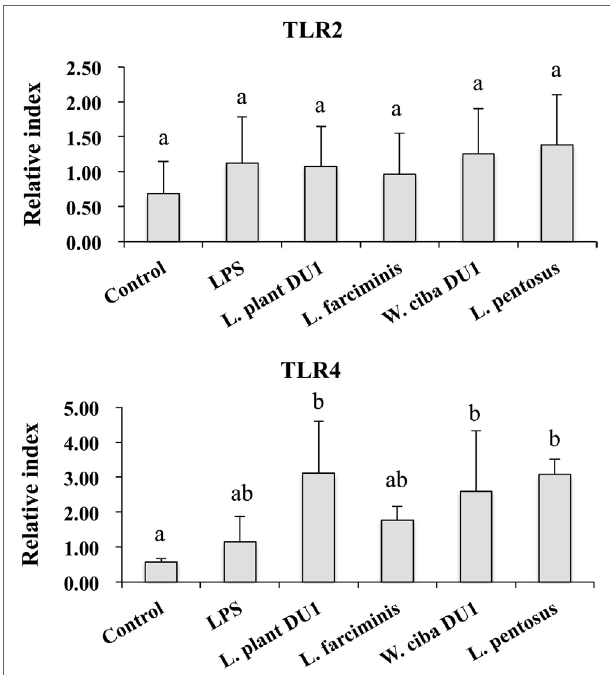
FigUre 6 | Effect of lactic acid bacteria (LABs) on expression of TLR2 and TLR4 on HepG2 sanitized THP-1 cells. In the co-culture setup, the apical side that contain HepG2 cells were stimulated with heat-killed LABs for 48 h, after which THP-1 cells that taken in the basolateral side was treated with LPS. After 12 h, the expressions of TLR2 and TLR4 were determined by RT-PCR. Cells treated with either medium or LPS alone were used as controls. The results presented as an average values (mean ± SD) of three independent experiments. Different superscript letters indicate significant differences at the 0.05 level.